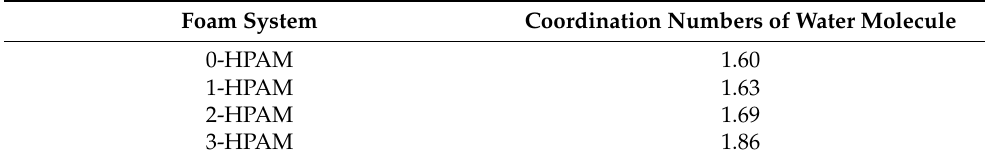
Table 5. Coordination numbers of water molecules in the hydration shells of foam systems with different HPAM concentrations.